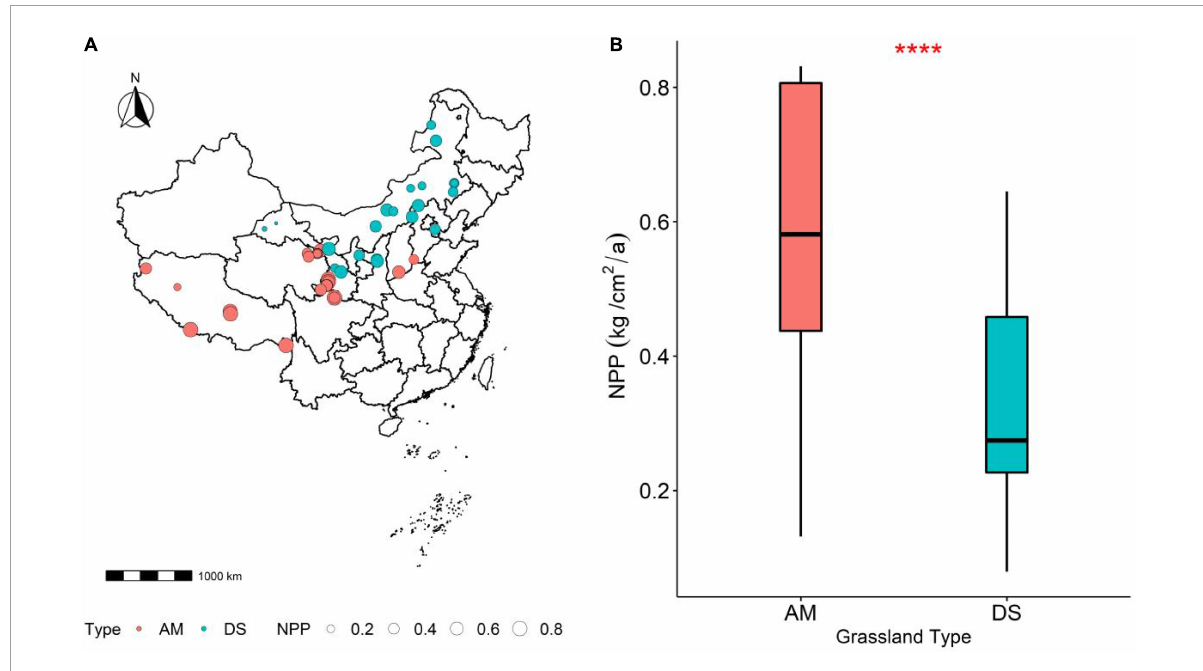
FIGURE1 Comparison of the variability of different grassland NPP. (A) Geographical location of the grassland plots in this study; (B) variability of the NPP of AM and DS. AM represents alpine meadows and DS represents desert steppes. ****Represents P <